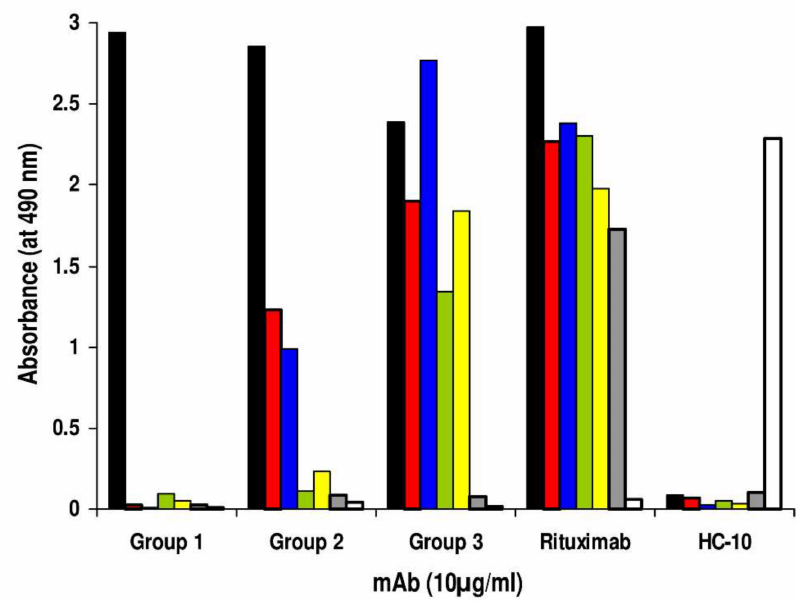
Figure 2. Binding assay to define the di ff erential reactivity of anti-Rp5-L mAb with a panel of Rituximab-specific peptides. Hybridoma-supernatants secreting anti-Rp5-L mAb were added to wells previously coated with Rituximab-specific peptides Rp5-L (black bar), Rp1-L (red bar), Rp10-L (blue bar), pASMLPD (green bar), Rev-pASMLPD (yellow bar), RpCD20-L (grey bar), and Qp-1a (white bar) for 4 hours at R / T. Peptide-antibody binding was detected with HRP-conjugated goat anti-mouse Ig. Rituximab, the anti-HLA class I mAb HC-10, and the peptide Qp-1a were used as controls. The data are representative of two